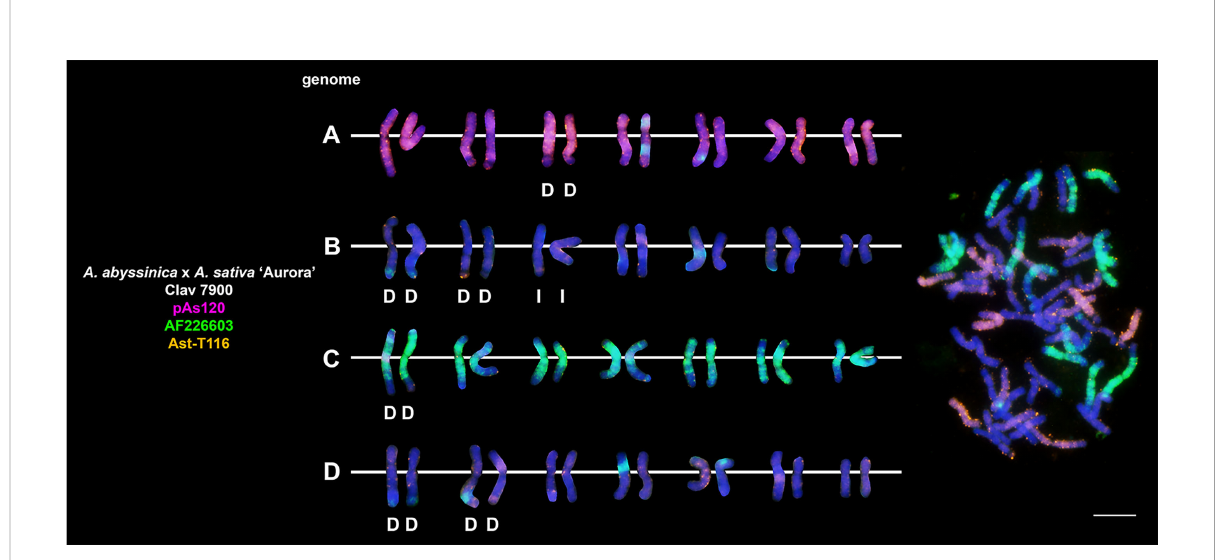
FIGURE 8 Fluorescence in situ hybridization with repetitive DNA probes to chromosomes of an amphiploid formed by crossing tetraploid A. abyssinica with A. sativa . Intergenomic translocations were visualized. D- distal translocation, I- interstitial translocation. Scale bar = 10 m